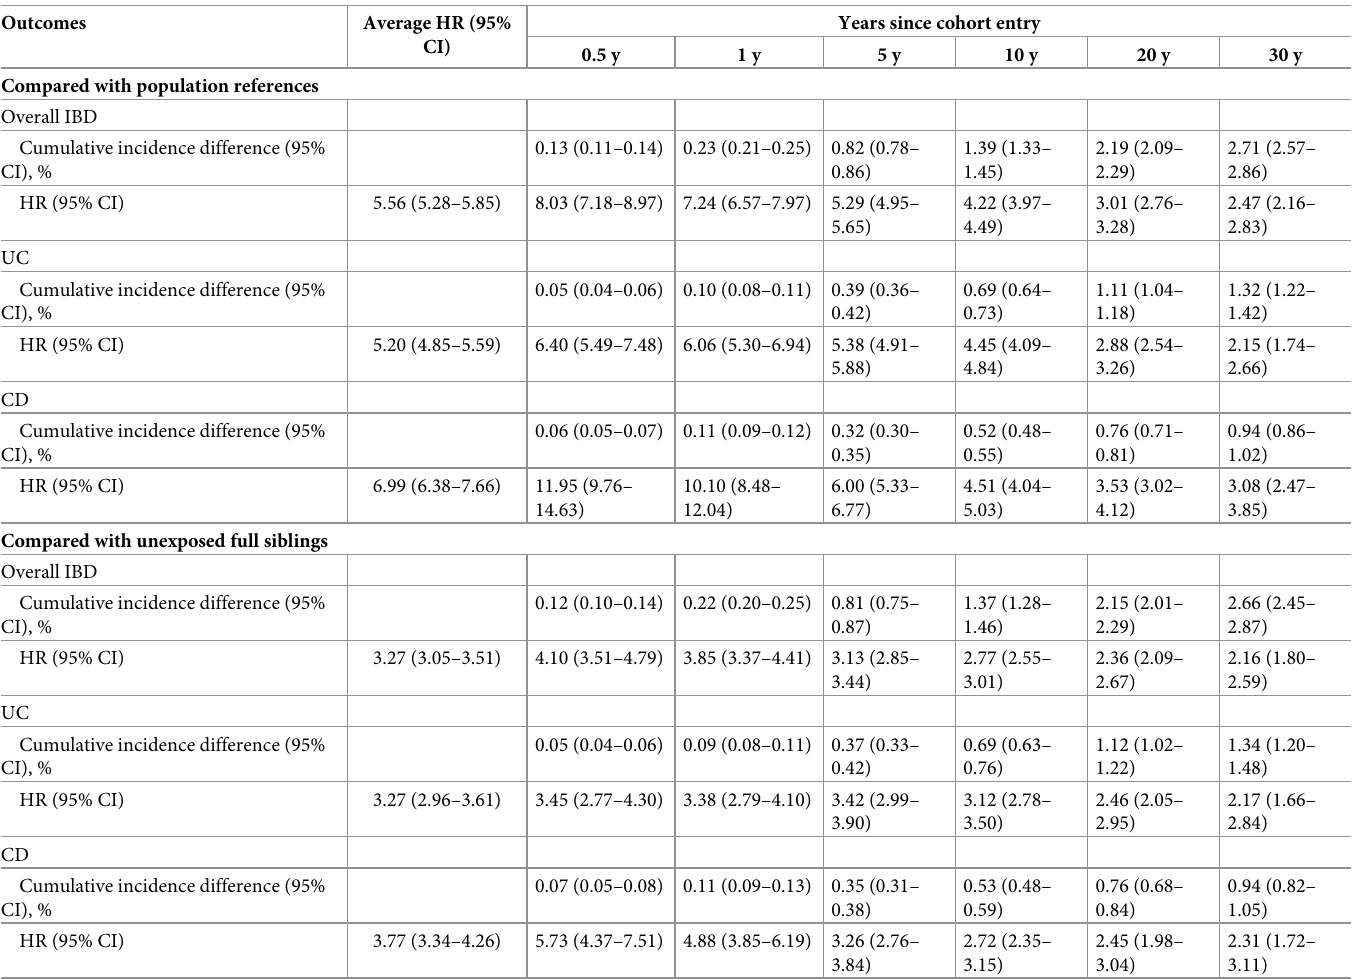
Table 2. IBD during follow-up in individuals with a lower GI biopsy result of normal mucosa.